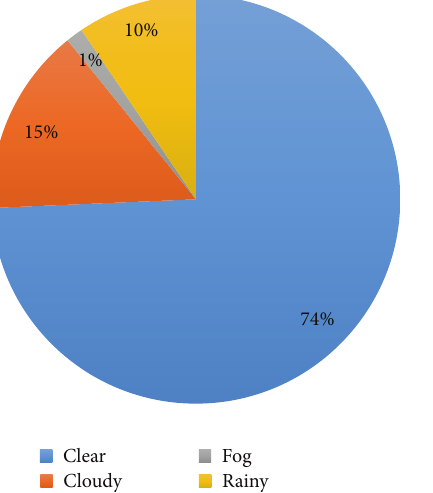
Figure 11: Distribution of weather conditions in e-bike fatal crashes.